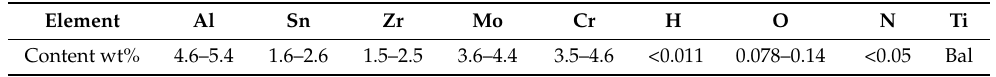
Table 1. Element composition of as-received TC17